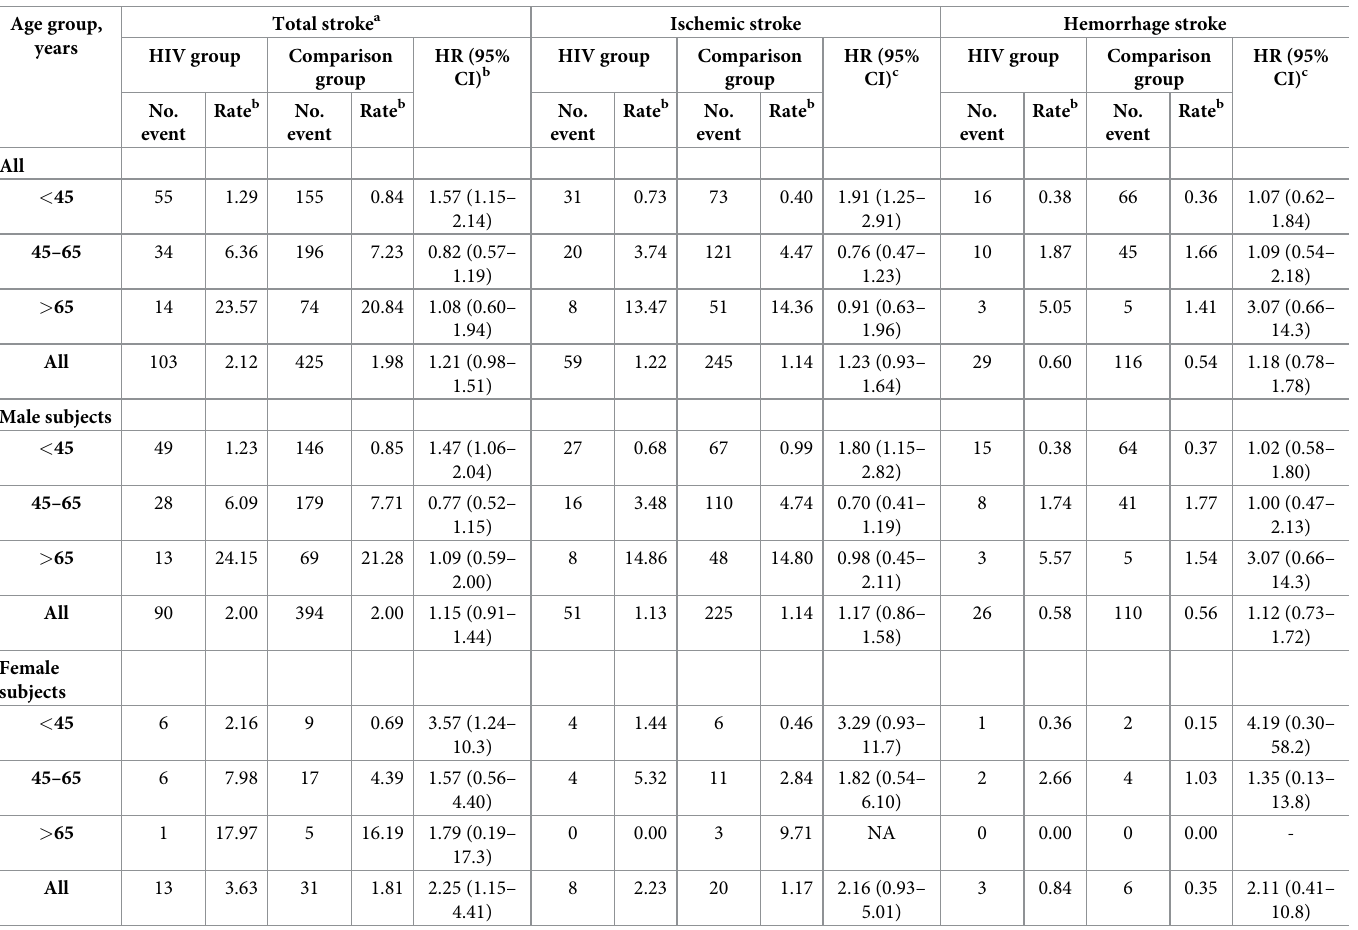
Table 2. Risk of stroke in relation to HIV infection by age and